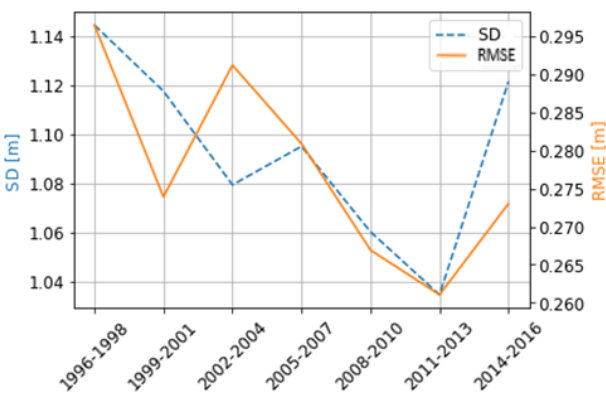
Figure 6. Standard deviation of H s (blue) and RMSE (orange) for each validation